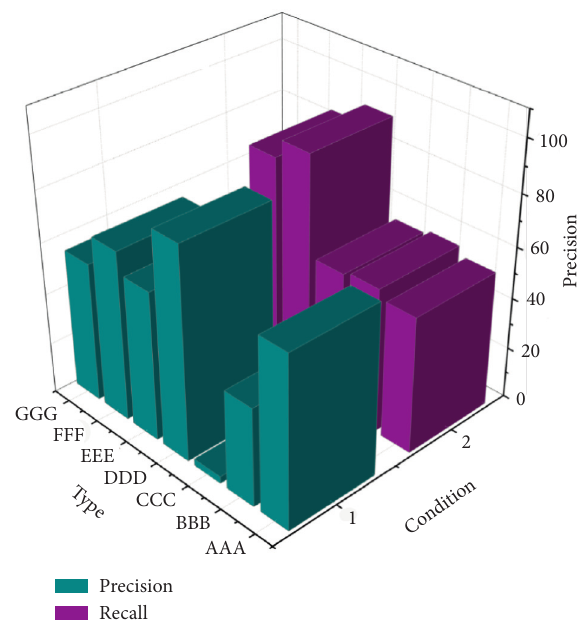
Figure 6: Average accuracy and recall rates using the balanced dataset on 7